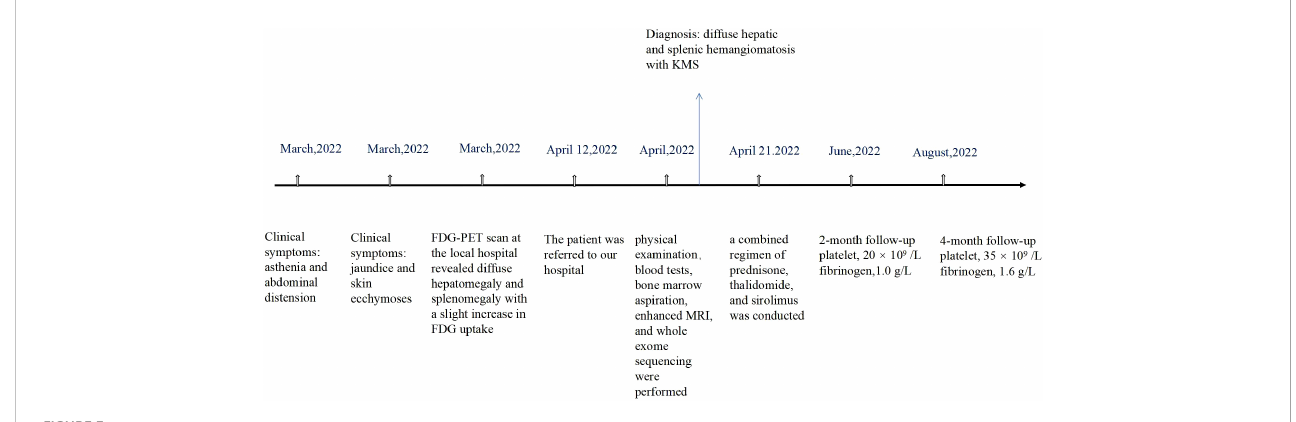
FIGURE 3 Timeline. FDG-PET, fl uorodeoxyglucose positron emission